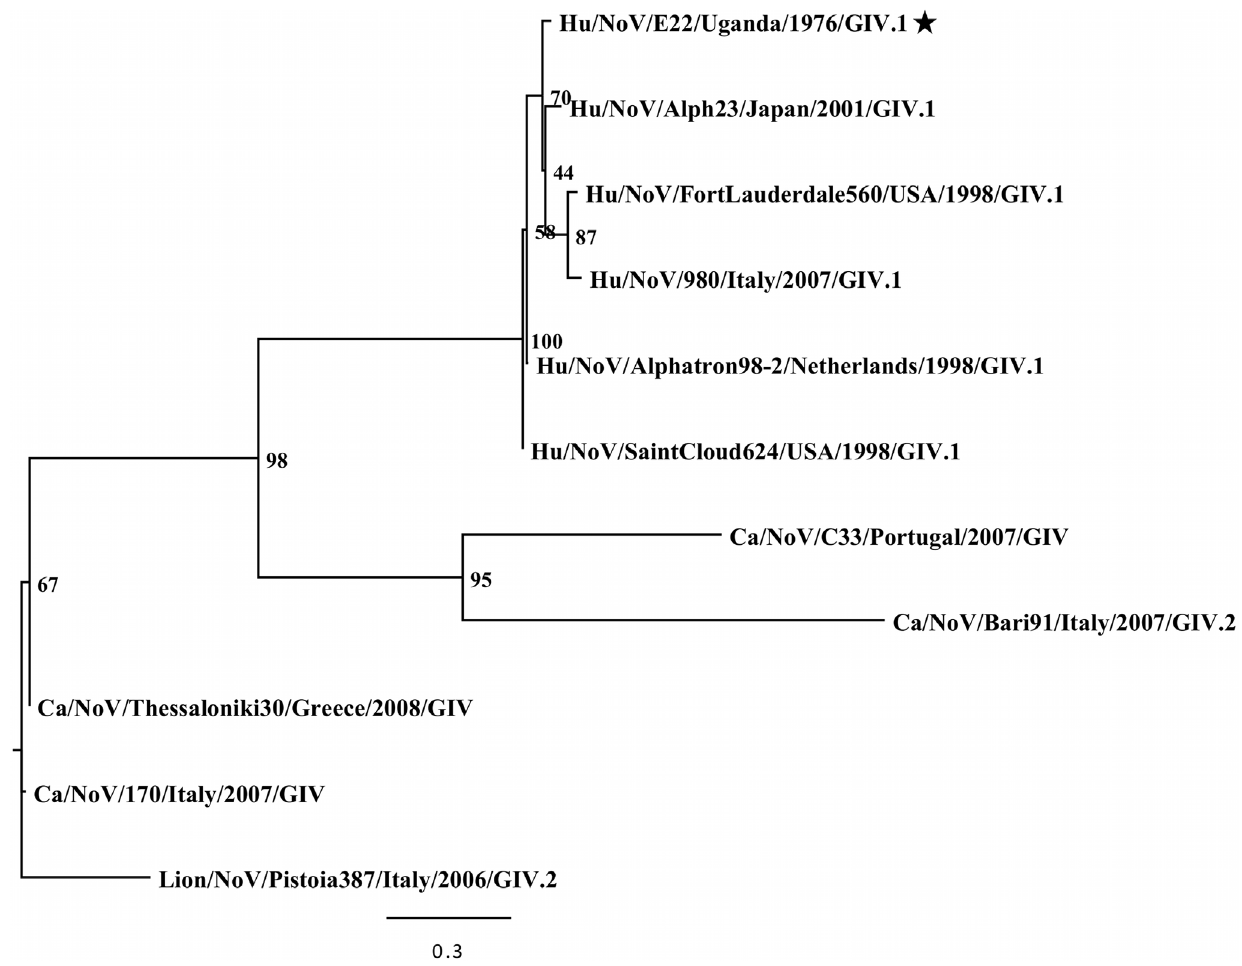
Figure 6. Maximum likelihood phylogenetic analysis of partial VP1 capsid sequences from GIV noroviruses. Bootstrap values are shown as percent values for major nodes. A black star indicates the sequence obtained from this study.